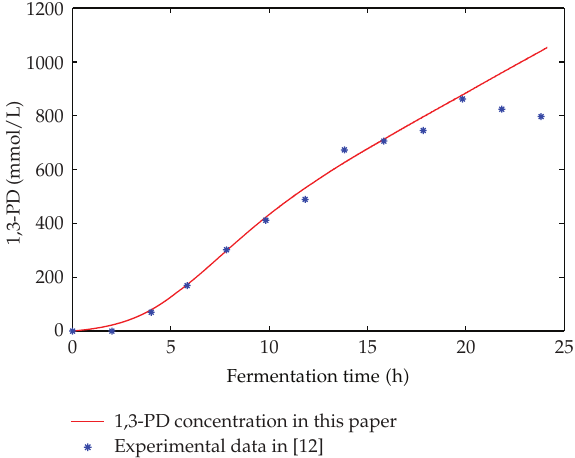
Figure 2: The concentration changes of 1,3-PD with respect to fermentation